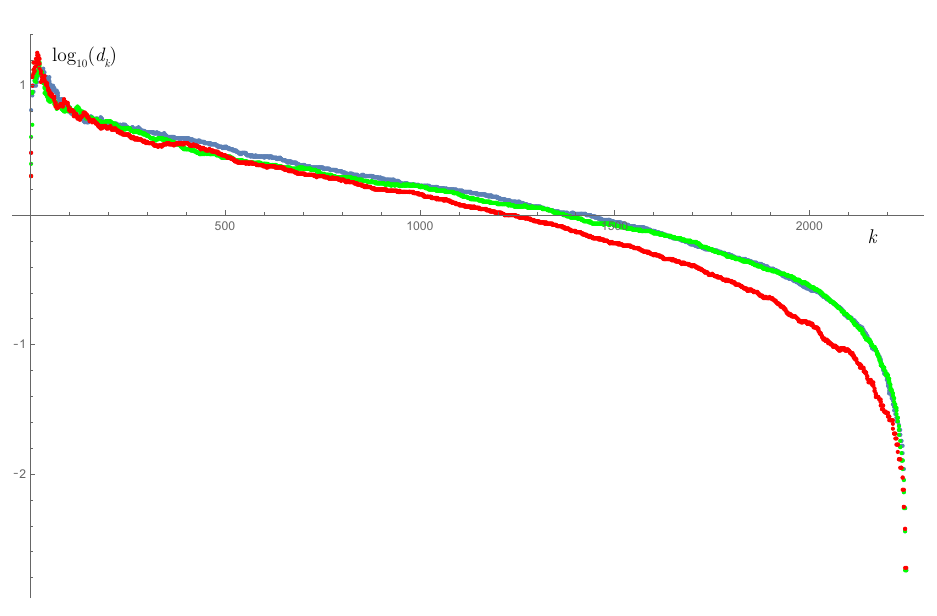
(cid:16) (cid:17) N out ( a k ) ( d k ) = log for each node a k in each layer k for three 10 10 N in ( a k +1 )